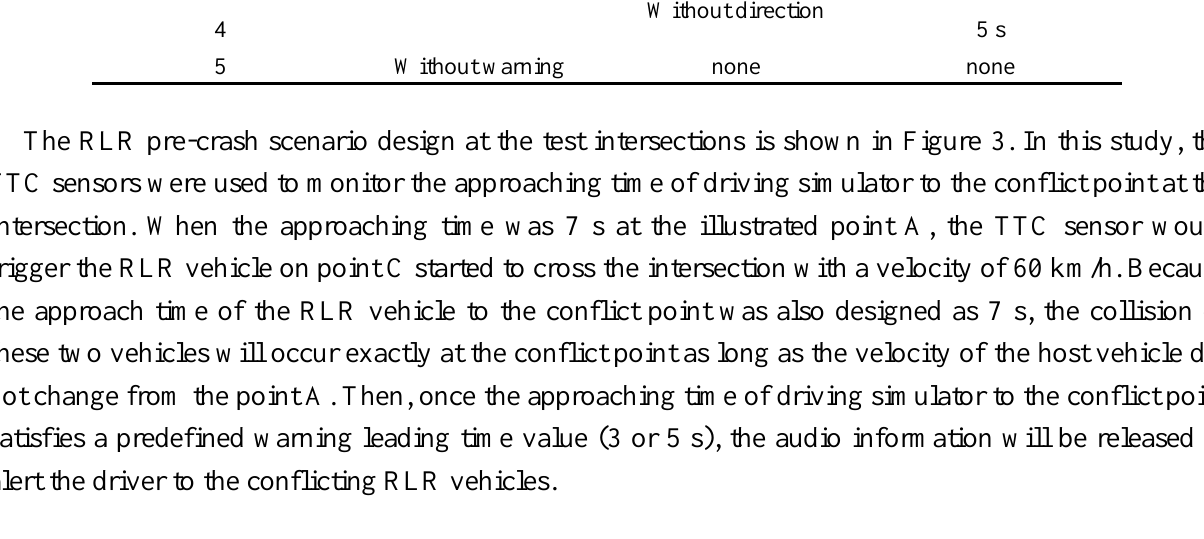
Figure 3. RLR pre-crash scenario design at the test